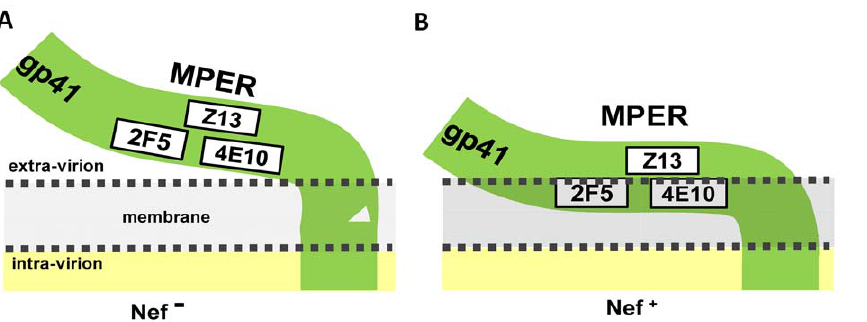
Figure 12. Model depicting the possible mechanism by which Nef specifically alters the accessibility of 2F5 and 4E10 MPER epitopes to nAbs. Schematic conformation of the MPER in relation to the viral membrane in the absence (A) or presence (B) of Nef. Nef, by altering the virion lipid composition, increases the strength of the association of the MPER with the viral membrane, decreasing specifically the accessibility of the epitopes for 2F5 and 4E10, but not Z13e1, which is located on the exposed side of the MPER.